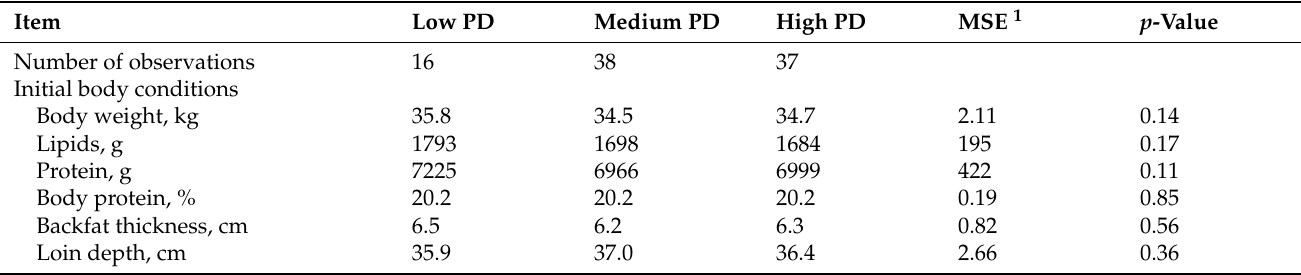
Table 2. Body composition and growth performance of growing barrows (35–60 kg body weight) fed daily tailored diets varying lysine (Lys) and threonine (Thr) levels and clustered in low, medium, and high protein deposition